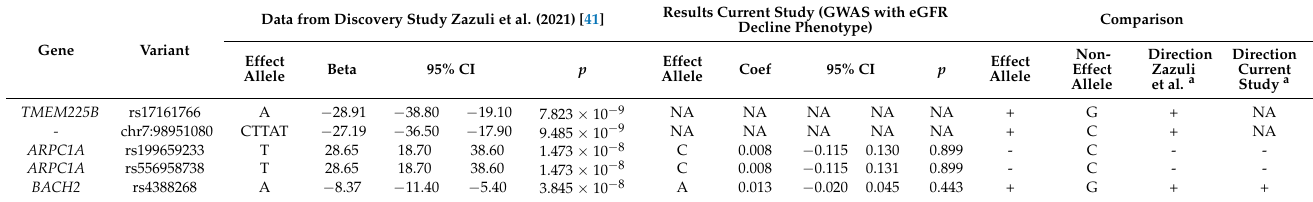
Table 4. Replication results of variants found to be statistically significantly associated by Zazuli et al. (2021)